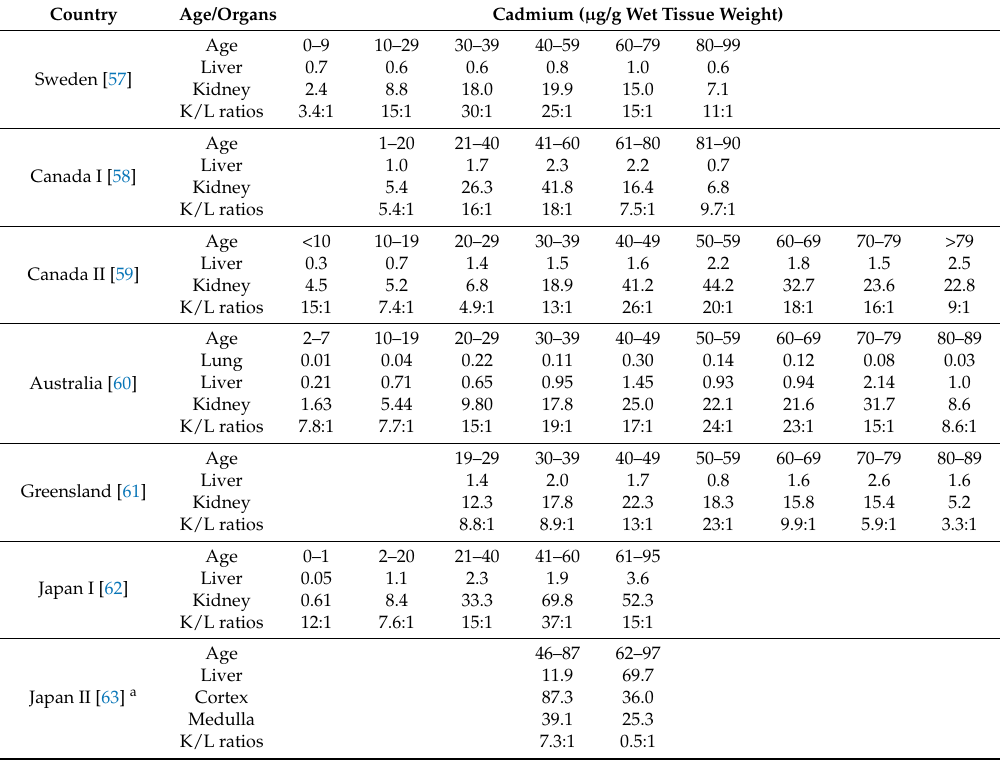
Table 1. Age- and organ-differentiated levels of cadmium accumulation. Country